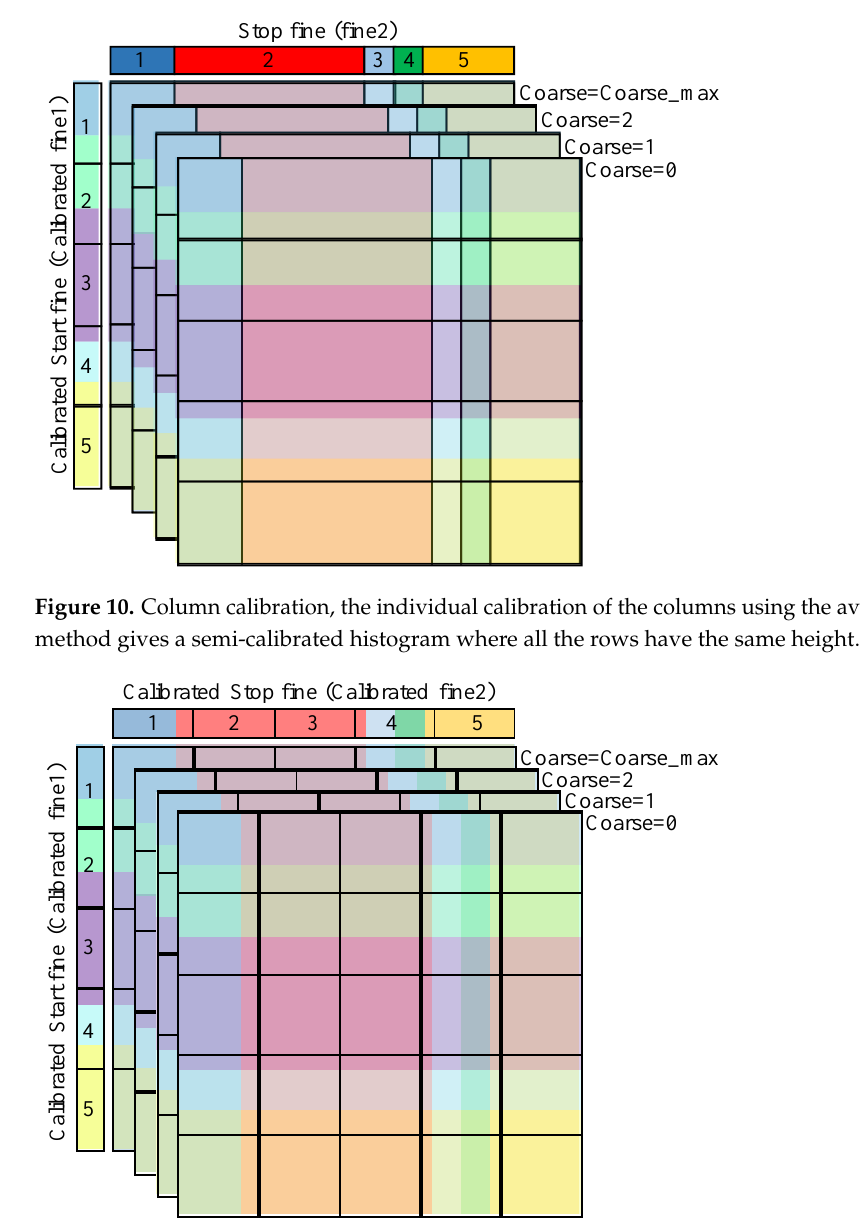
Figure 11. Row calibration; the average-bin-width calibration is applied to the rows, resulting in a calibrated 3-D histogram with identical cell size. 4. Step 4: Building 1-D calibrated